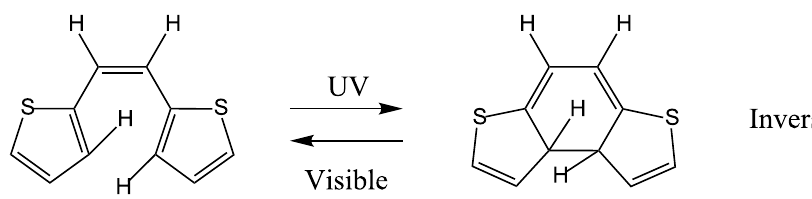
Figure 2. PES profiles for an inverse-type model molecule. The level of the